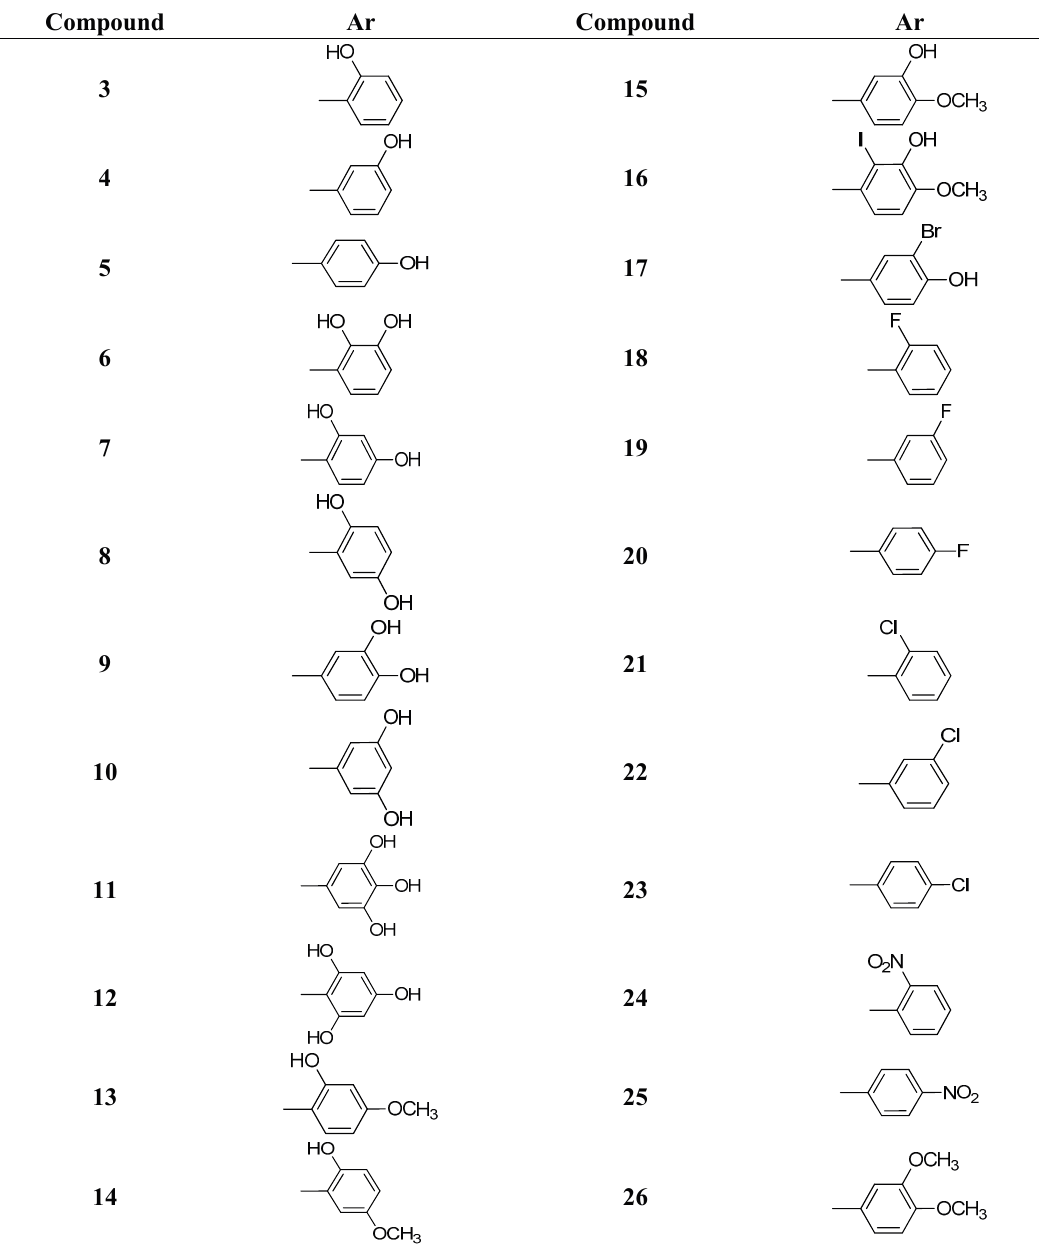
Table 2. Structures of bisindolylmethane Schiff base